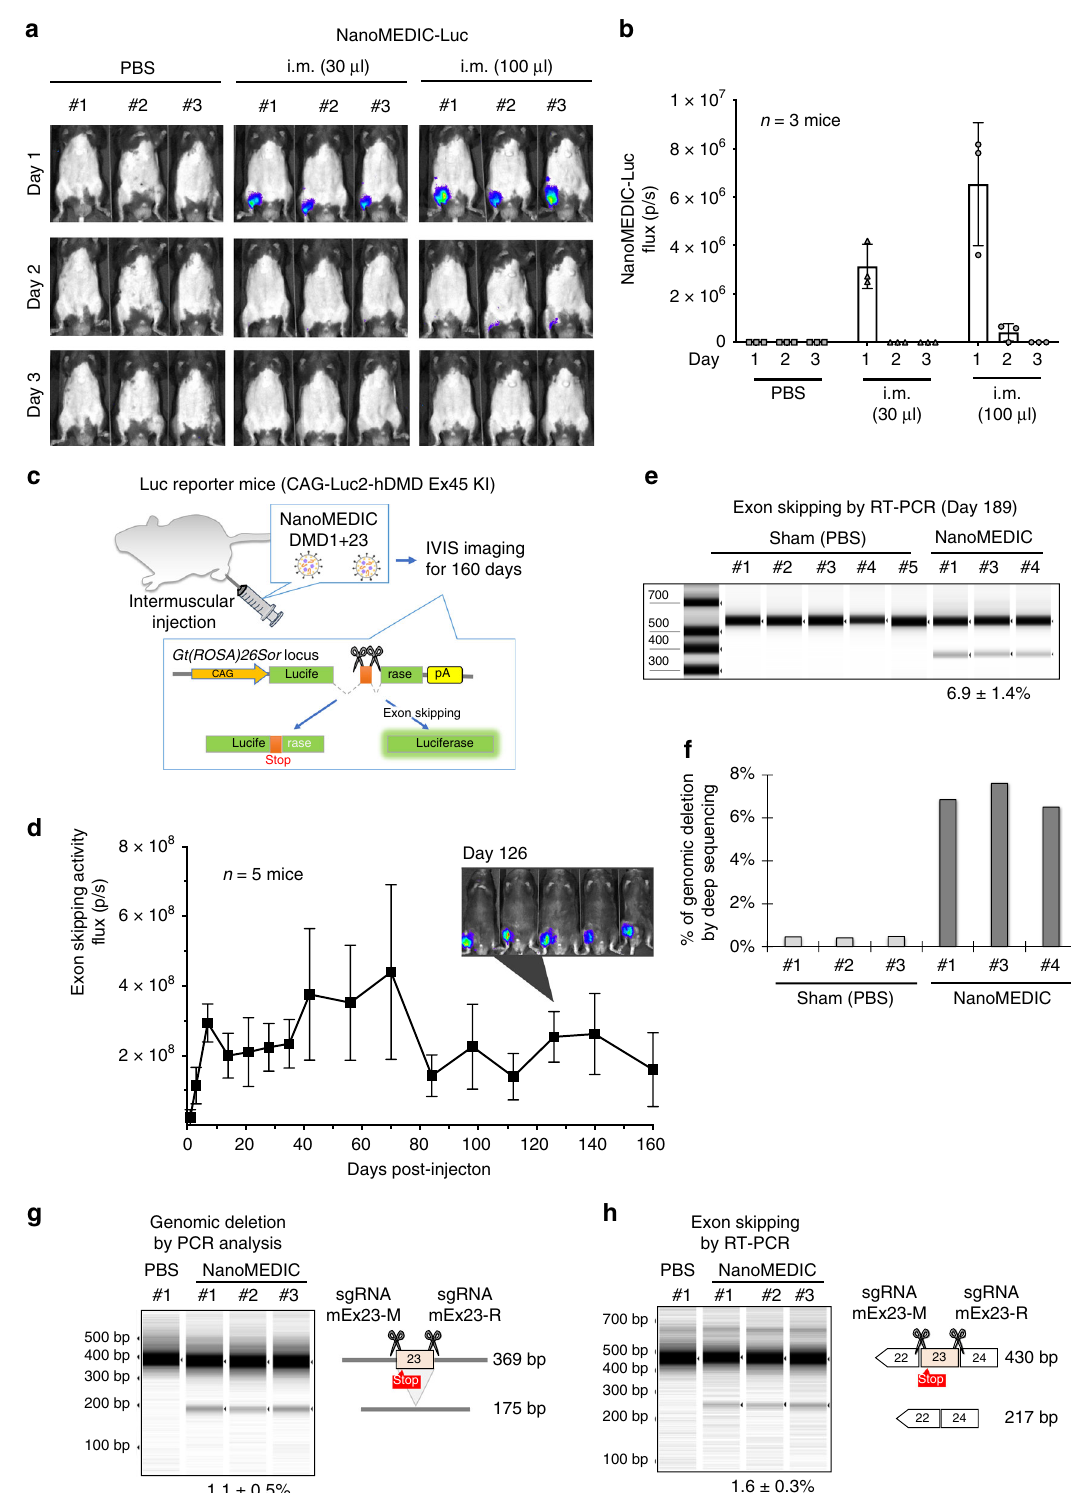
PCR. We detected 1.1% large deletion (194 bp) between the two gRNA target sites (Fig. 6g). Furthermore, the exon 23 skipping ef fi ciency of mRNA extracted from the TA muscle of the injected mice was 1.6% (Fig. 6h). The editing ef fi ciency of the mouse dystrophin locus was lower than that of the Luc reporter, possibly owing to the difference of epigenetic status between the reporter gene